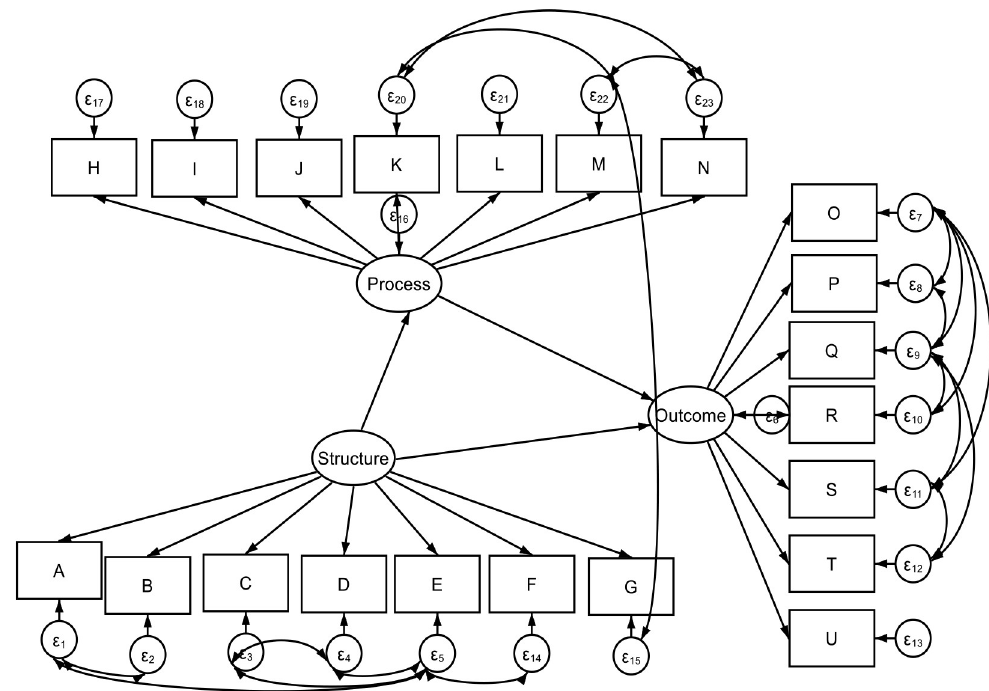
Fig 1. Hypothesised structural equation